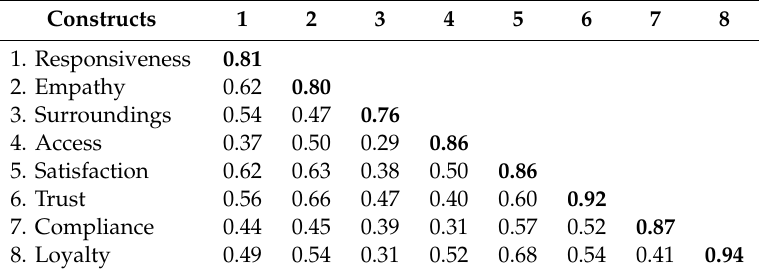
Table 4. Correlations between constructs.